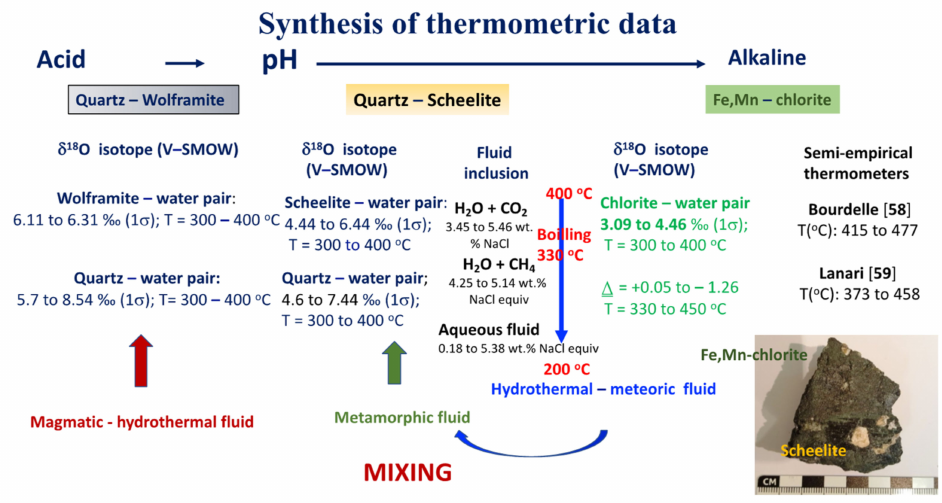
Figure 14. Synthesis of microthermometry and oxygen isotope data correlated with semi-empirical chlorite thermometers